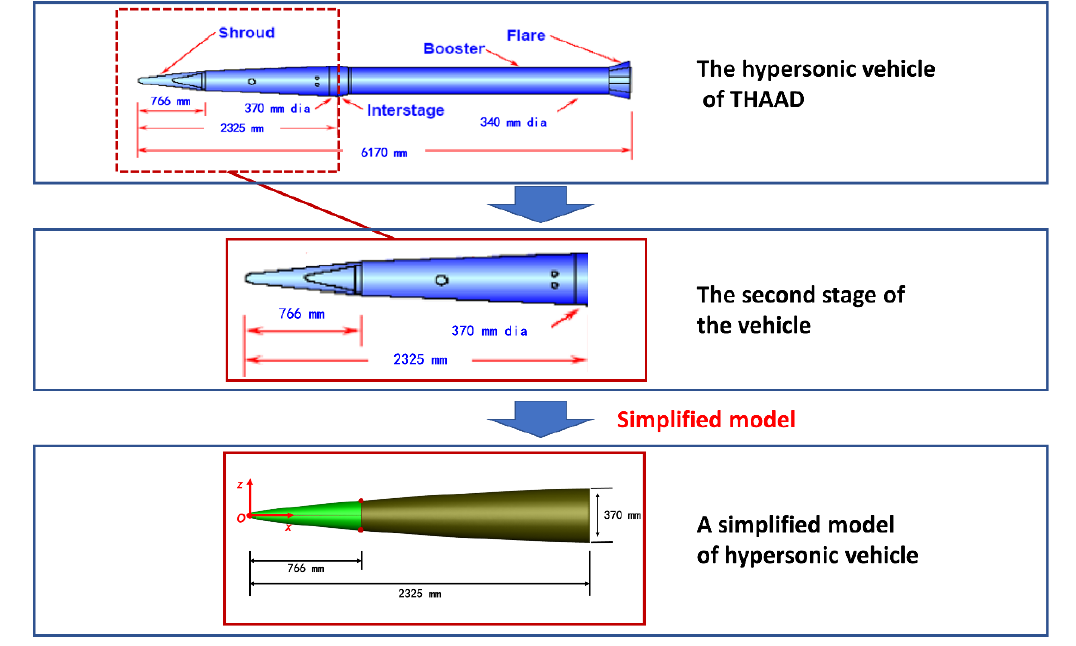
Figure 2. Simplified model of the hypersonic THAAD vehicle.